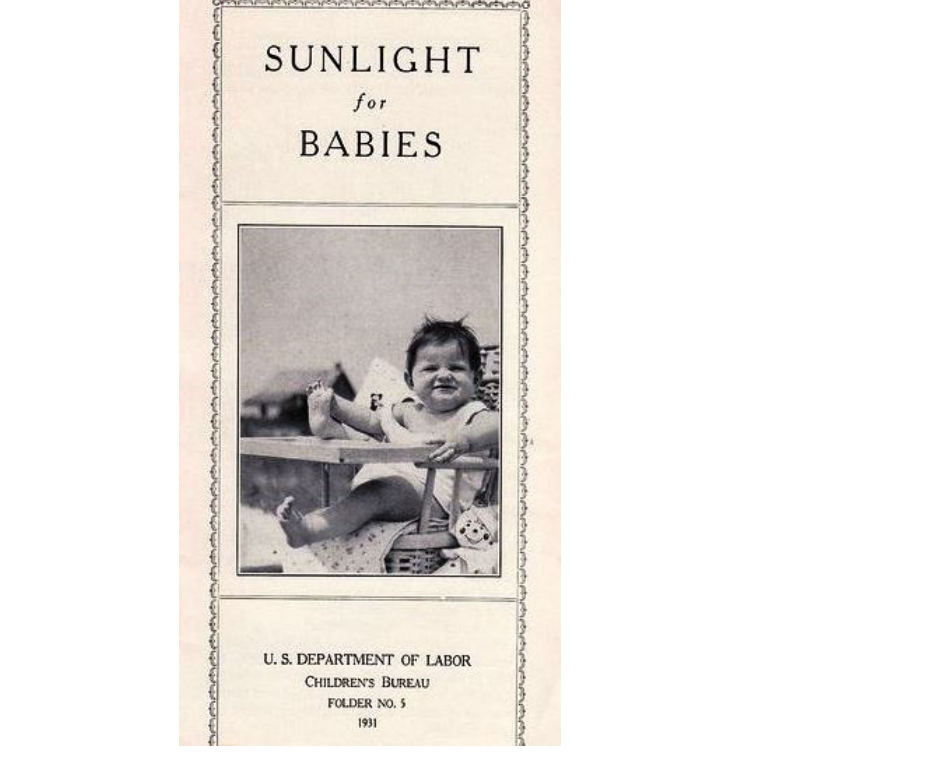
Figure 22. 1931 Children’s Bureau Pamphlet. The 1935 edition of Infant Care encouraged sunbathing for baby in order to acquire a healthy tan, as illustrated in Figure 23.